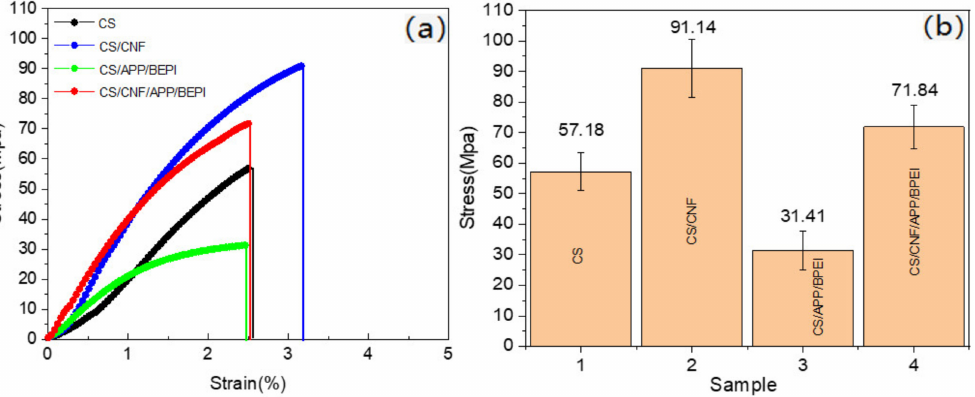
Figure 8. The ( a ) stress–strain curves and ( b ) tensile strength of the different CS-based composite